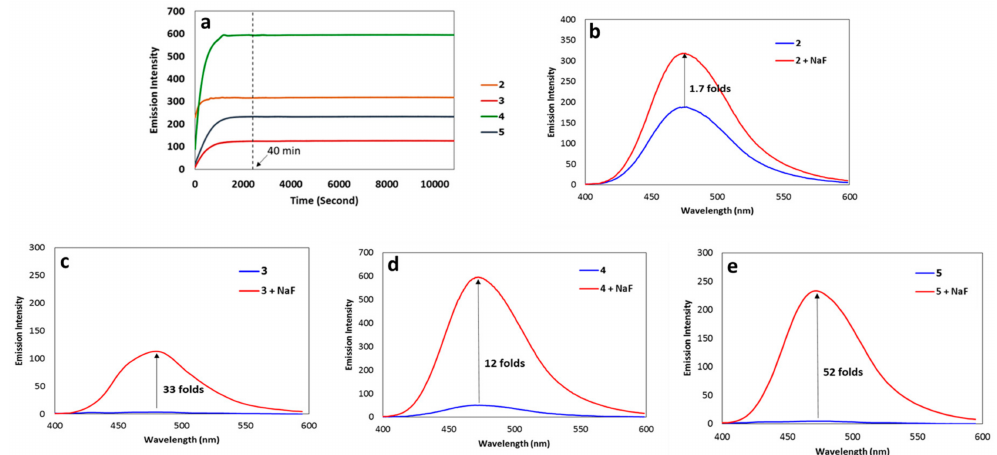
Figure 4. ( a ) Time courses of fluoride-promoted Si-O bond cleavage reaction of 2 , 3 , 4 , and 5 (2 µ M) after addition of NaF (1 mM) in HEPES buffer solution pH 7.4 (contain 0.8% MeCN) and ( b – e ) Fluorescence spectral changes of 2 ( b ), 3 ( c ), 4 ( d ), and 5 ( e ) (2 µ M) before (blue line) and after (red line) addition of NaF (1 mM) at 3 h incubation time in HEPES buffer solution pH 7.4 (contain 0.8%